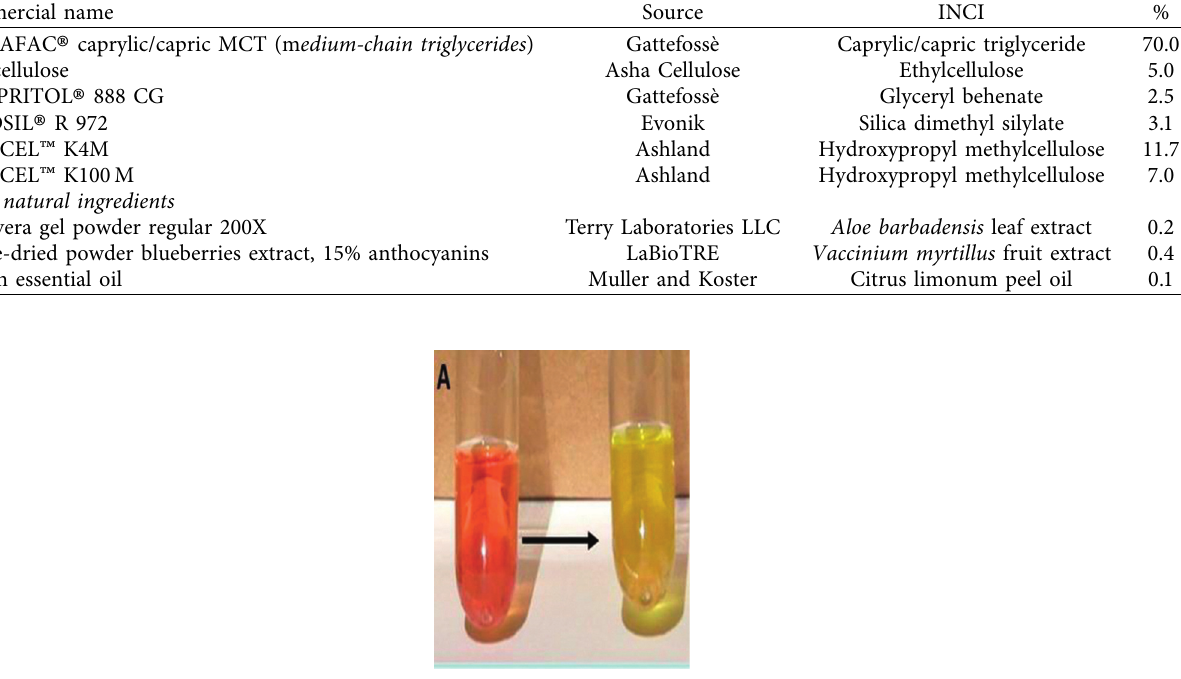
Figure 1: Lacto-Counter Assay (LCA) reagent with the phenol-red shifts the color from red to yellow due to its acidification by the lactobacilli metabolism.